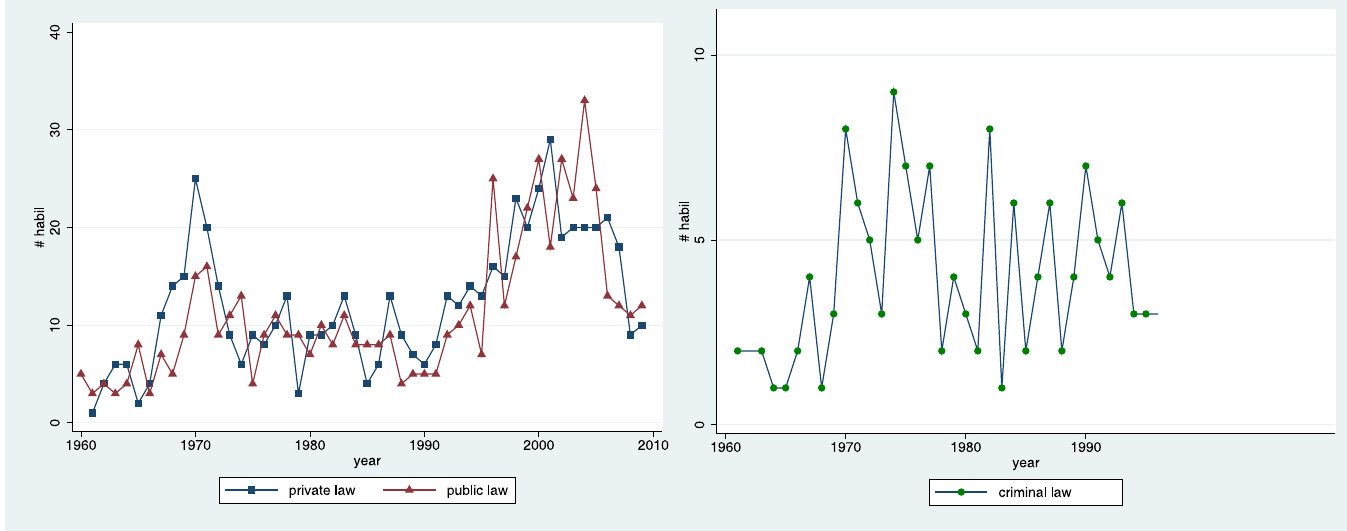
Fig 3. Development in the Three Institutionalised Sub-disciplines. Total number of habilitations per year.